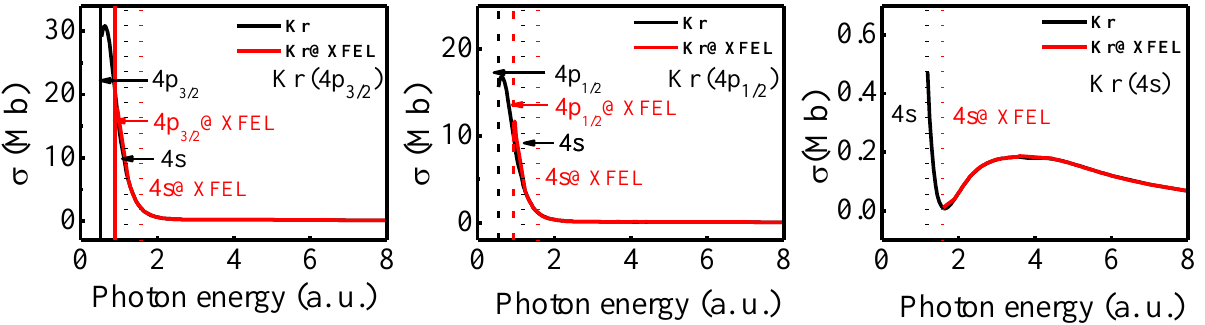
Figure 11. Photoionization cross section (σ) of 4p 3/2 (Left), 4p 1/2 (Middle), and 4s (Right) subshells of Kr (black) and Kr@XFEL (red). Solid, dashed, and dotted vertical lines represent the threshold for 4p 3/2 , 4p 1/2 , and 4s thresholds of free (black) and confined atom (red), respectively.